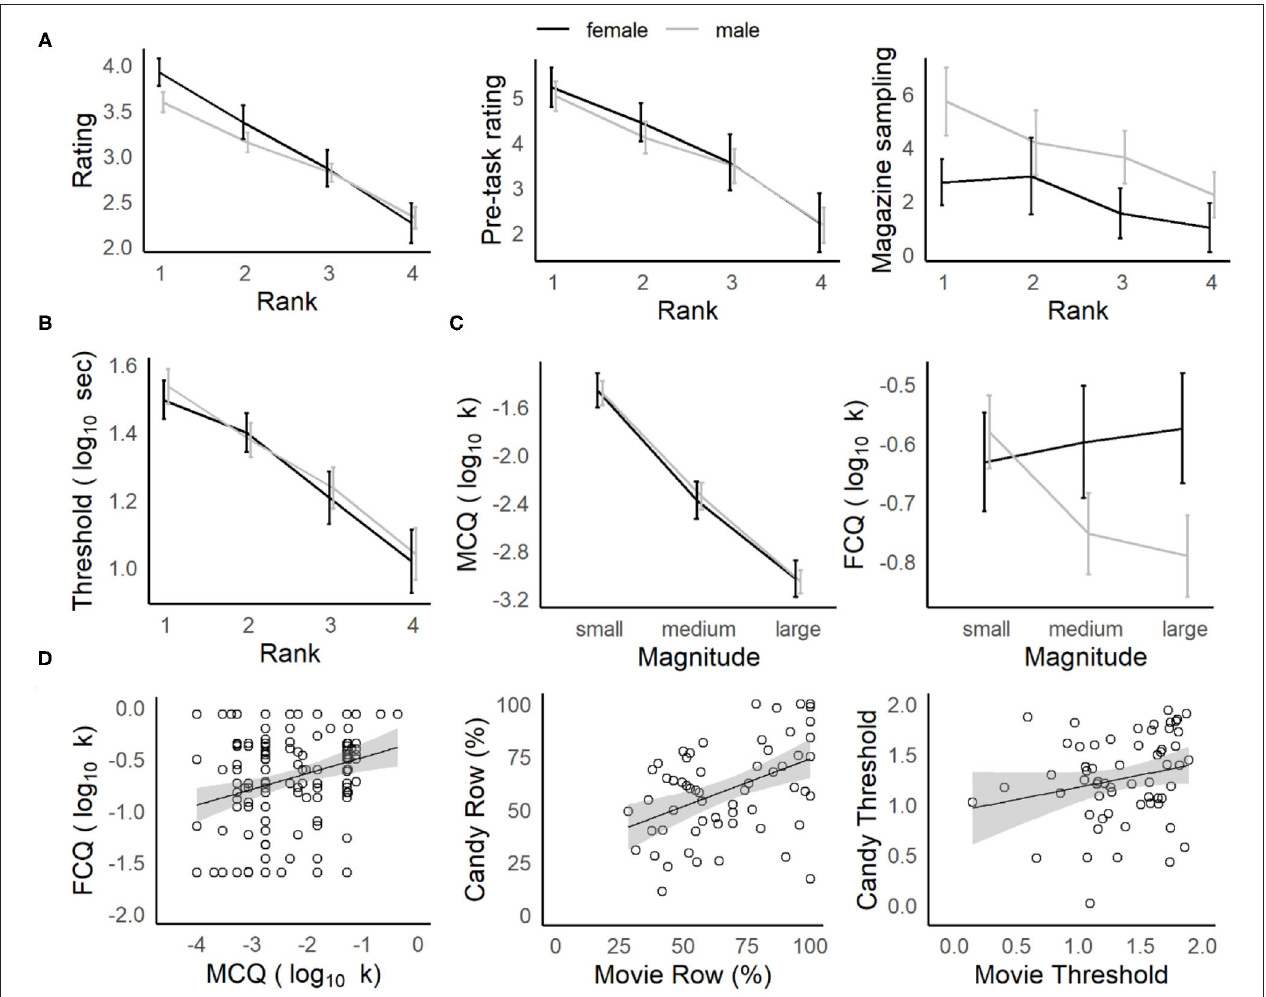
FIGURE 2 | Characterizing navigation tasks and comparison to delay-discounting. (A) Stated vs. revealed preferences. Average star ratings ( left ) in the Movie Row, and pre-task enjoyment ratings ( middle ) in the Candy Row decreased as a function of the post-experiment ranking. Participants were more likely to retrieve their favorite food rewards on the Candy Row ( right ). (B) Delay thresholds decreased significantly across ranks (favorite to least favorite). (C) Delay-discounting (k) for hypothetical money rewards ( left ) did not differ by gender, and decreased as a function of reward magnitude. For hypothetical food rewards ( right ), males showed a similar sensitivity to magnitude, while females did not. (D) Comparison of navigation tasks and delay-discounting measures. Overall delay-discounting for hypothetical money and food rewards was correlated ( left ) in the survey measures, as was the number of actual food and movie rewards earned ( middle ) and a similar trend was seen for log-transformed delay thresholds ( right